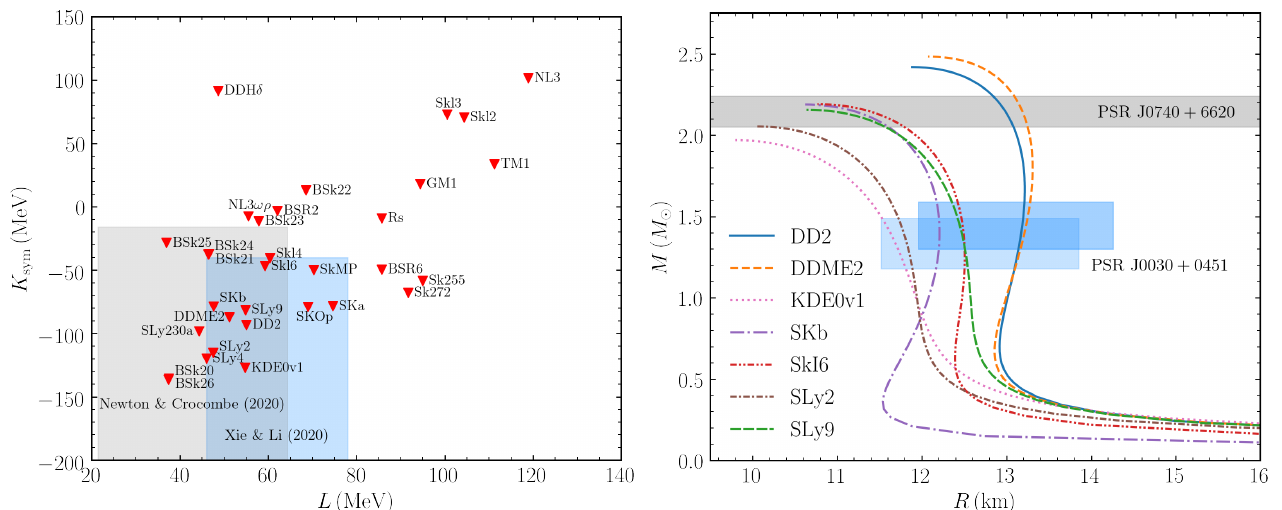
Figure 12. ( Left ) K sym versus L for 33 unified neutron star EOSs from Fortin et al. [117] in comparison with their 68% confidence boundaries from analyzing neutron observables (Xie and Li) [67], as well as terrestrial experiments and theoretical calculations for the PNM EOS (Newton and Crocombe) [118]. ( Right ) Mass–radius correlations of the EOSs filtered by the K sym versus L constraints in comparison with the observational constraints. Taken from